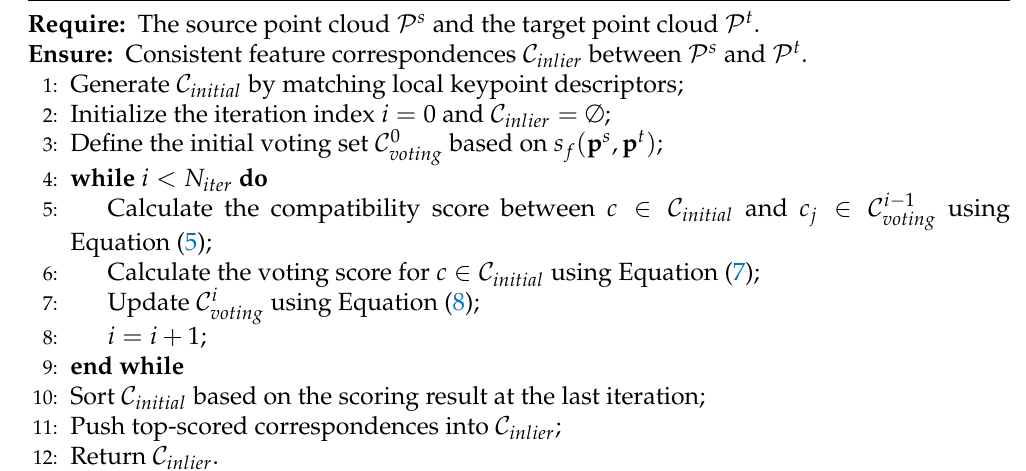
Algorithm 1 Feature matching for point clouds based on